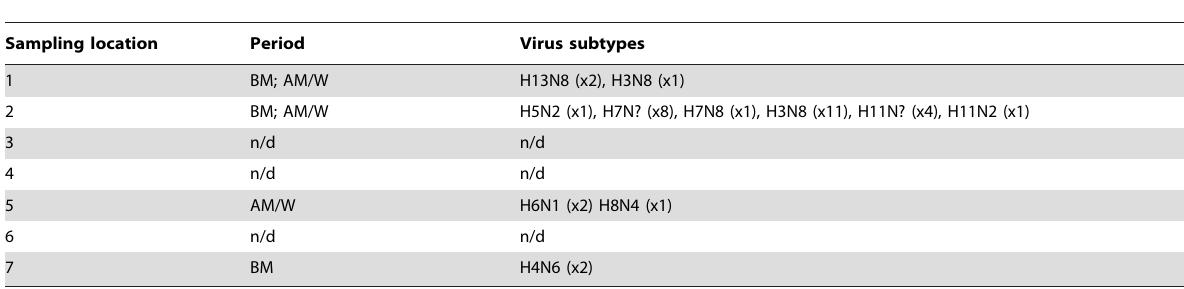
Table 4. Avian influenza virus subtypes detected during the